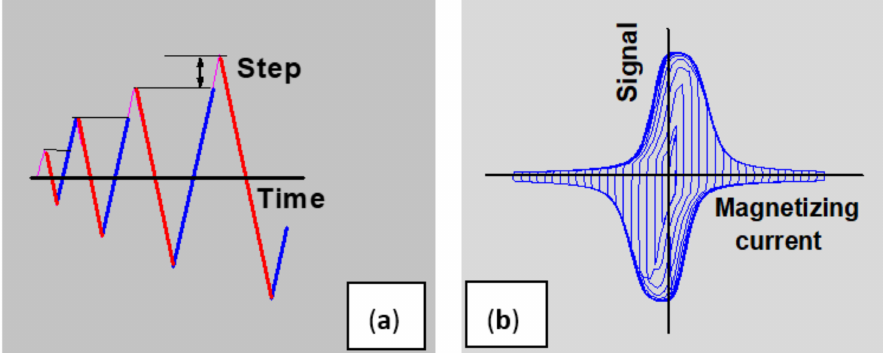
Figure 7. The time variation of the magnetizing current ( a ) and the measured permeability loops ( b )